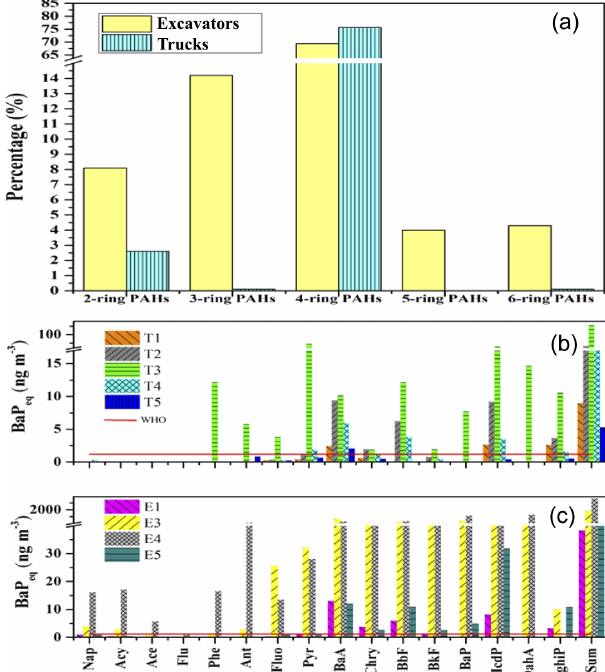
Figure 8. Percentages of each ring PAHs to total PAHs (a) . BaPeq for parent PAHs in each tested trucks (b) and excavators (c)